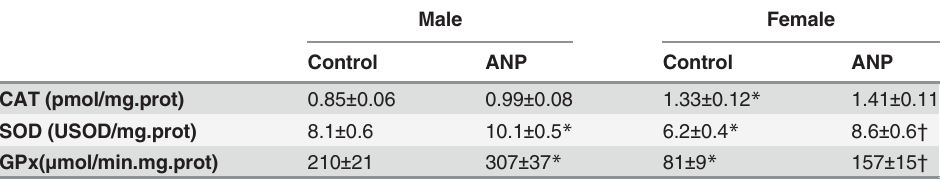
Table 2. Effect of chronic treatment with ANP on the enzymes involved in renal oxidative state of male and female SHR.